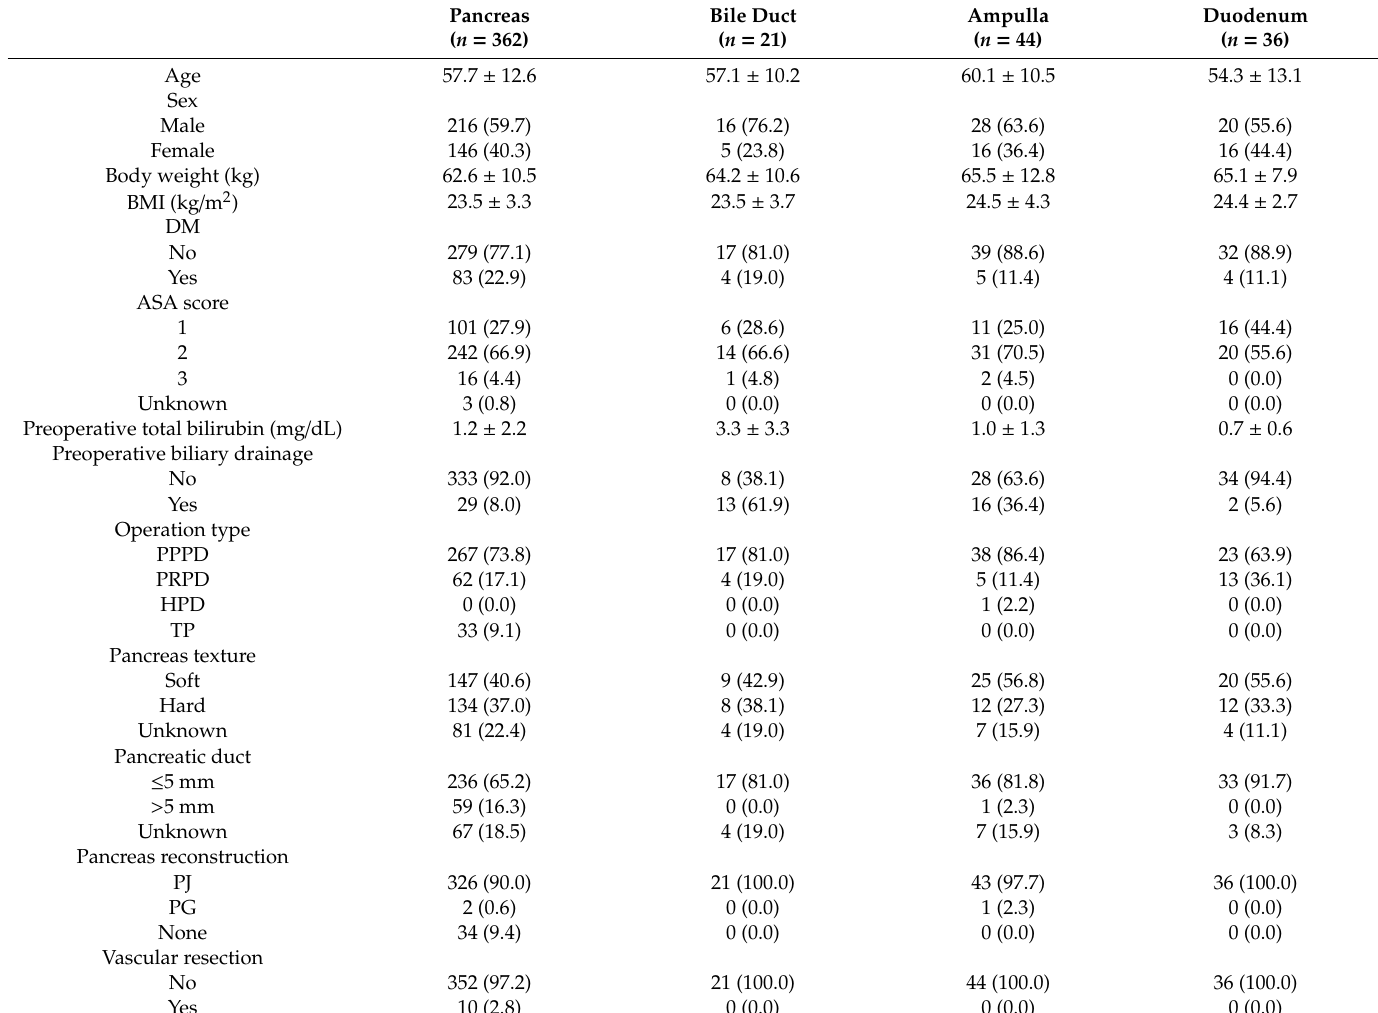
Table 1. Clinical, operative, pathologic, and postoperative features of 463 patients with non-malignant disease. (Mean ± Standard deviation and number